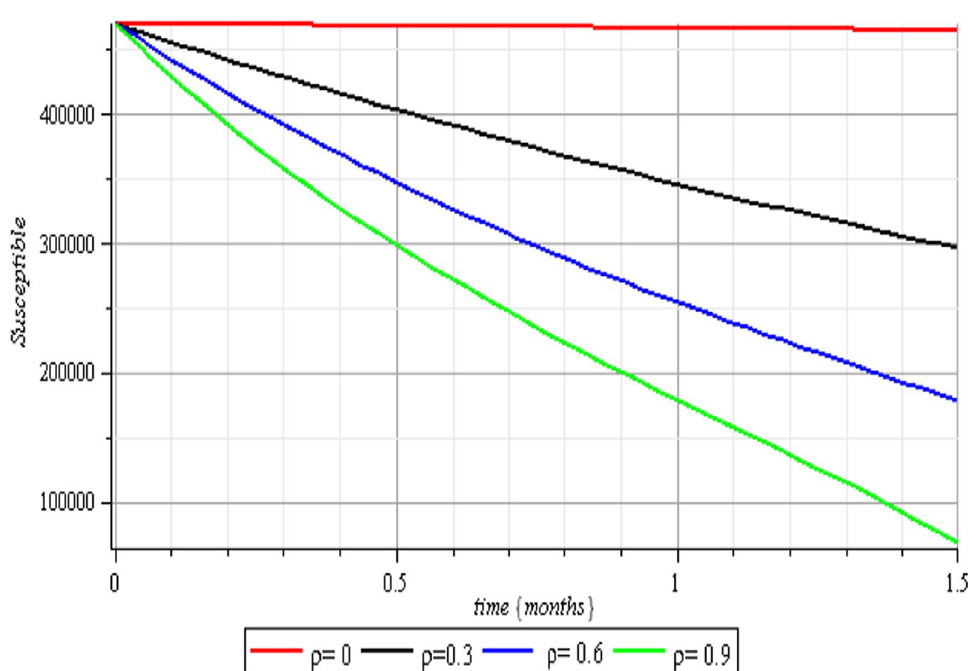
Fig. 7 Vaccination effects on the susceptible